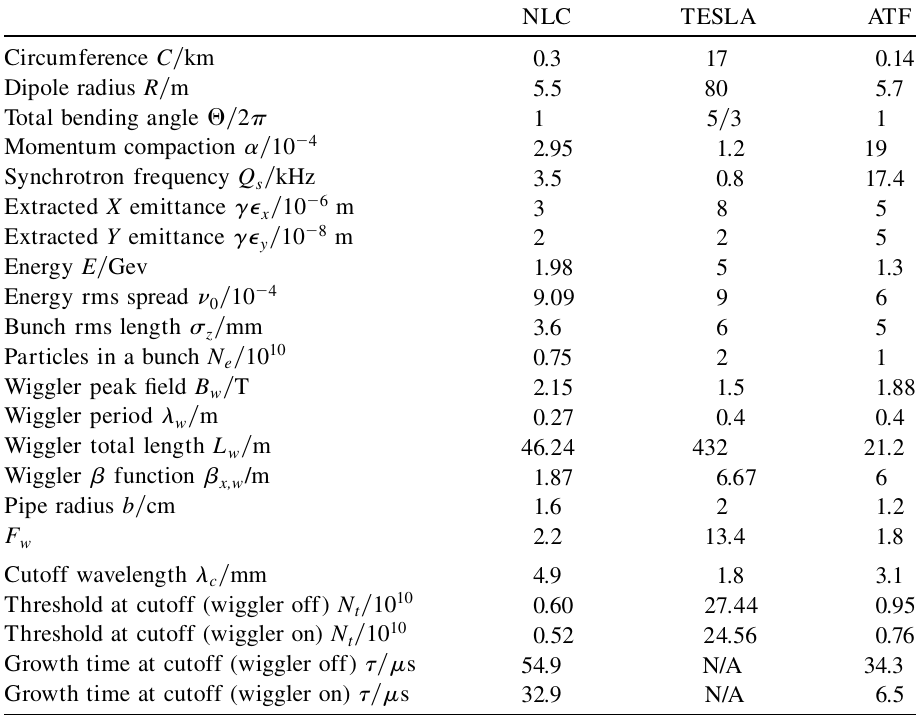
TABLE I. Parameters and results for the NLC main damping ring [16], the TESLA damping ring [17], and the KEK ATF prototype damping ring [18]. The parameter F Eq. (19), is the ratio of the ISR power emitted in the wiggler to that emitted in the arc bending